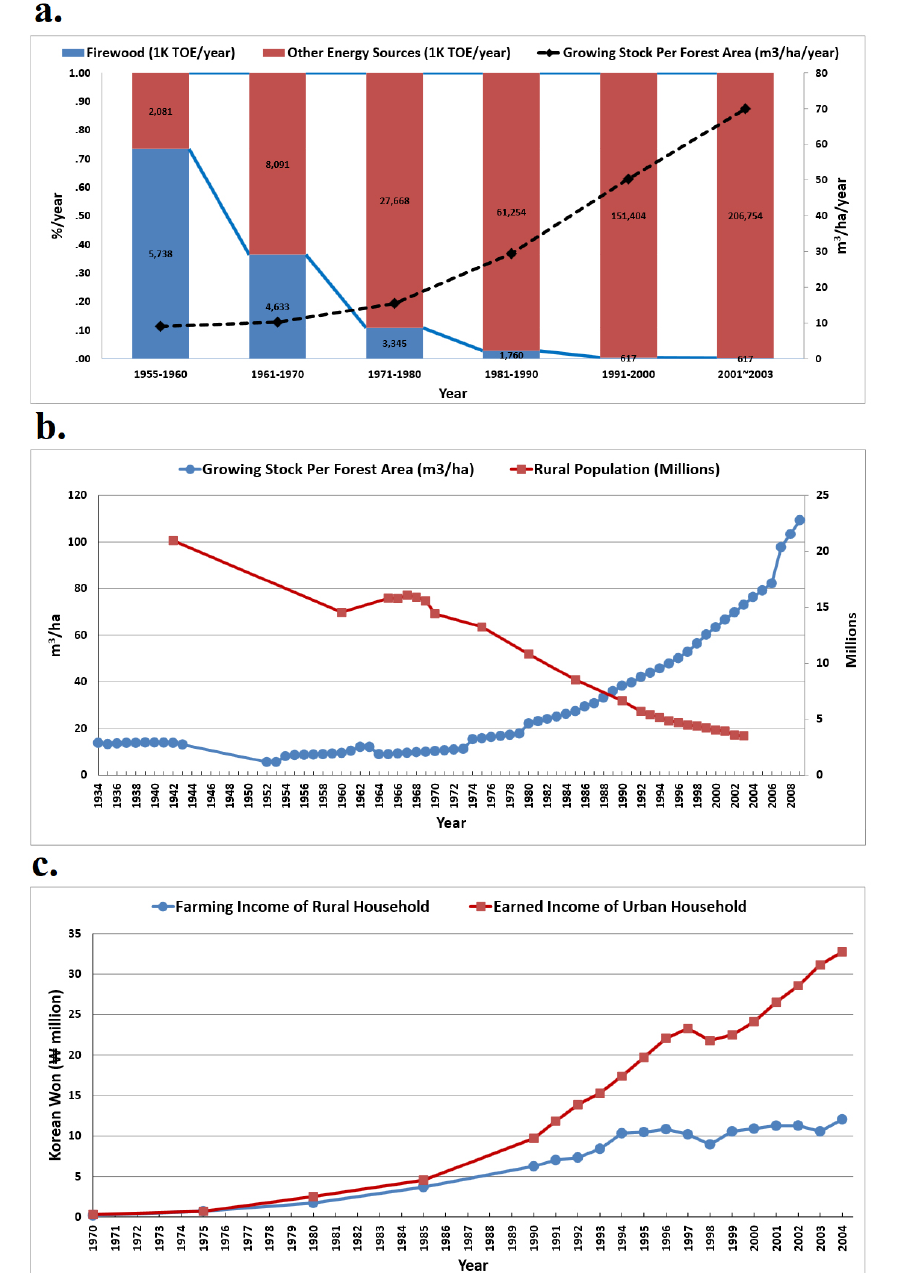
Fig. 2 . Changes in the broader context. A) Trends in average primary energy consumption and volume of growing stock from 1955 to 2003 (Source: KCC 2001, KESIS 2013). Other energy sources include coal, oil, gas, nuclear power, and hydro-power (TOE: tons of oil equivalent). B) Trends in rural population and volume of growing stock from 1934 to 2009 (Source: Bae and Lee 2006, BOK 2013, KFS 2010). The lines between the markers are linear interpolations. Note that the data before 1952 concerns the entire Korean Peninsula. C) Trends in earned income of urban household and farming income of rural household from 1970 to 2004 (Source: MAF